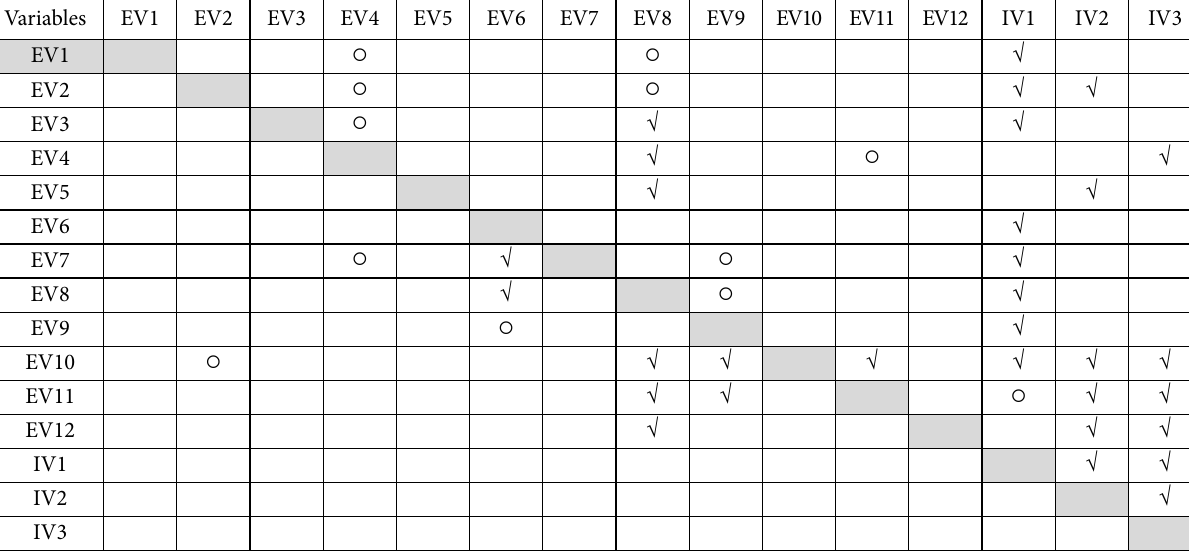
Table 5. Potential relationships between